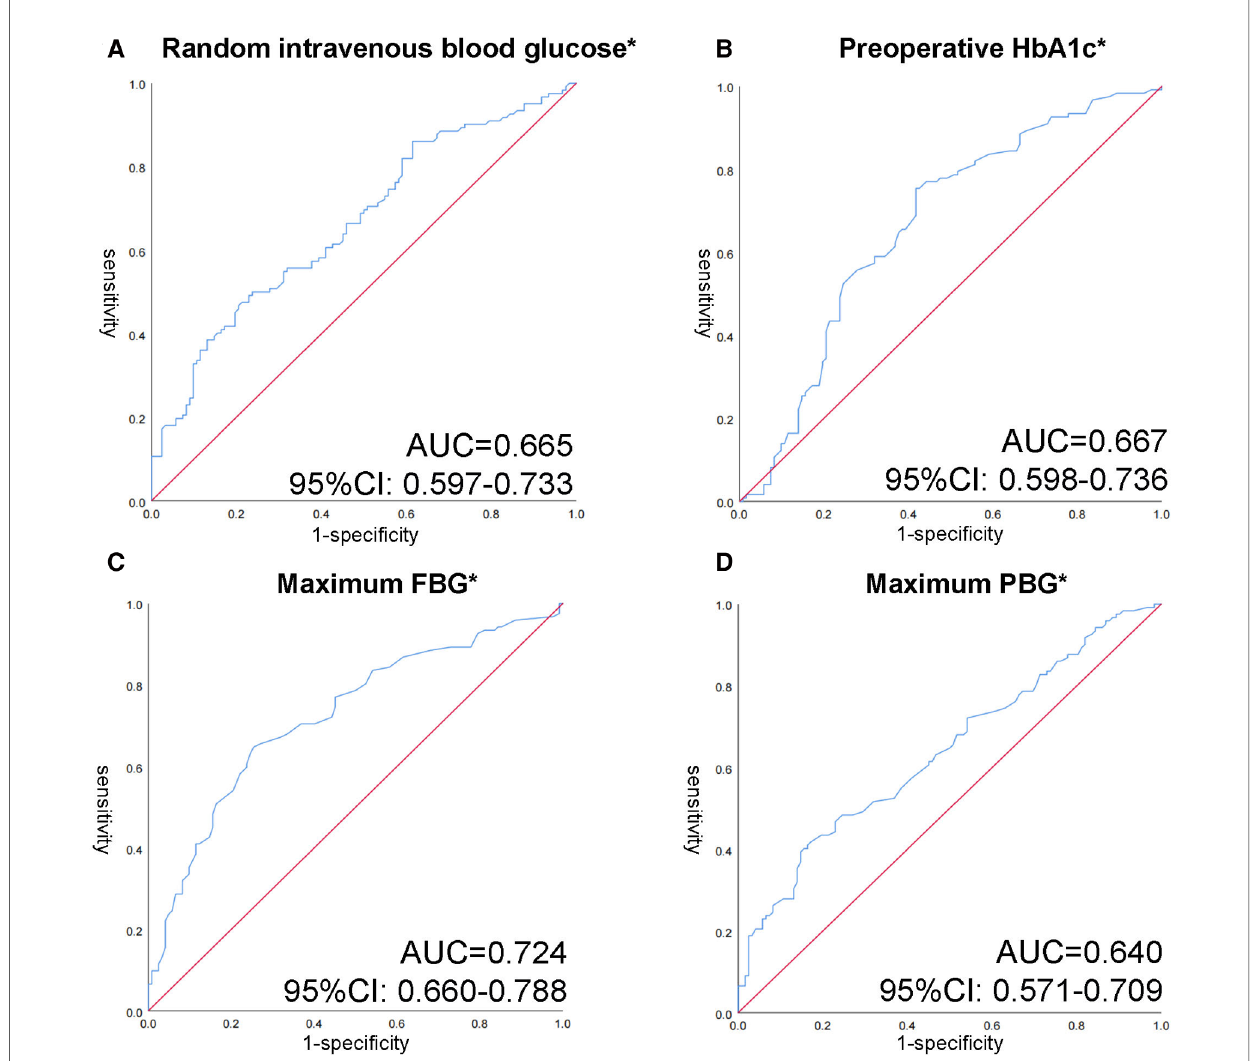
FIGURE 2 Receiver operating characteristic (ROC) curves of different glycemic indicators in patients with anal fi stula and T2DM. ( A ) ROC curve of random intravenous blood glucose. ( B ) ROC curve of preoperative HbA1c. ( C ) ROC curve of maximum FBG. ( D ) ROC curve of maximum PBG. * p <0.05 with Wilcoxon rank sum